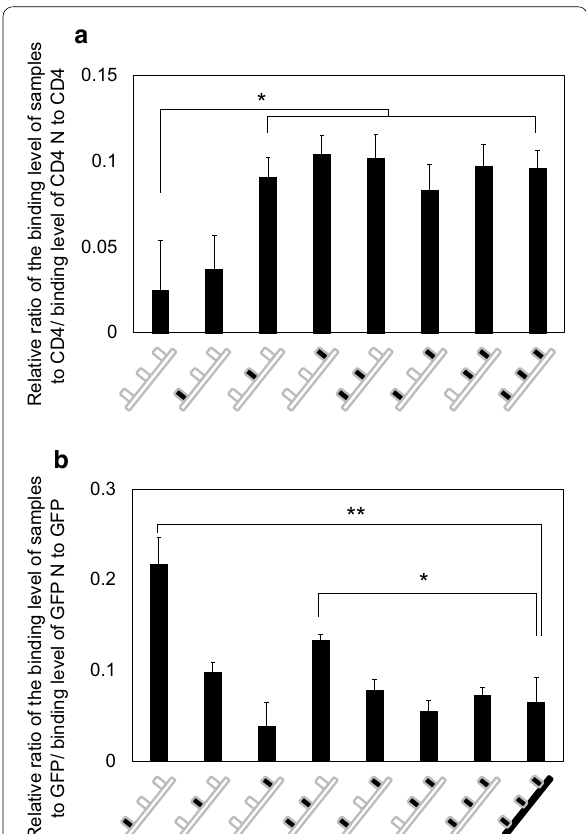
Fig. 4 Relative binding abilities of chimeric nanobodies to CD4 ( a ) and GFP ( b ). See also Fig. 1c for details of the illustration. Long block: nanobody scaffolds, small block: CDRs, white block: amino acid sequences derived from GFP-nanobody, black block: amino acid sequences derived from CD4-nanobody. a Relative response of chimeric nanobodies to CD4 compared to the response of CD4-nanobody. See also Additional file 1: Table S4 for the binding level in each experiment before normalization. b Relative response of chimeric nanobodies to GFP compared to the response of GFP-nanobody. See also Additional file 1: Table S5 for the binding level in each experiment before normalization. N bar mean SD, **p < 0.01, *p < = ±